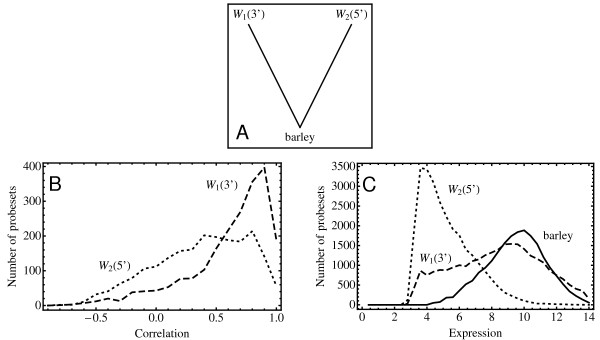
Expression differences between wheat 3' and 5' probesets. Comparison of expression profiles for wheat and barley allows an assessment of the reliability of the wheat 5' probesets. Homologous clusters of the type shown in Panel A suggest the simultaneous presence of both a 3' (W1) and 5' (W2) wheat probeset for the same gene that, at the same time, is homologous to a particular barley gene. The correlation of the expression profiles of these 3' and 5' probesets are shown in Panel B. On average, the profiles obtained from the 5' probesets show significantly lower correlation with that of their barley homologs than do the 3' probesets. This can also be seen in the distribution of the expression values themselves in Panel C. In general, expression values as measured by the 5' probesets tends to be much lower than those of their barley counterparts (solid line), while the signal from the corresponding 3' probesets shows a distribution roughly similar to that of the barley homologs.